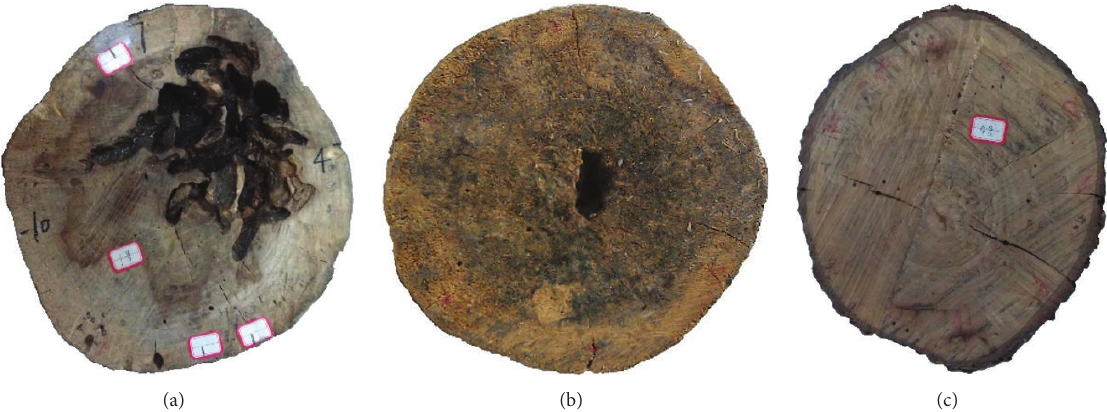
Figure 6: Photos of the wood samples used in this work. (a–c): (a) serious defect, (b) early defect, and (c) sound sample.